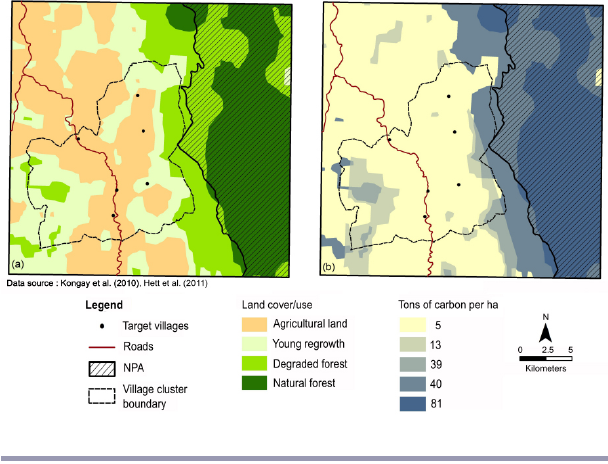
Fig. 3. Methodological framework combining